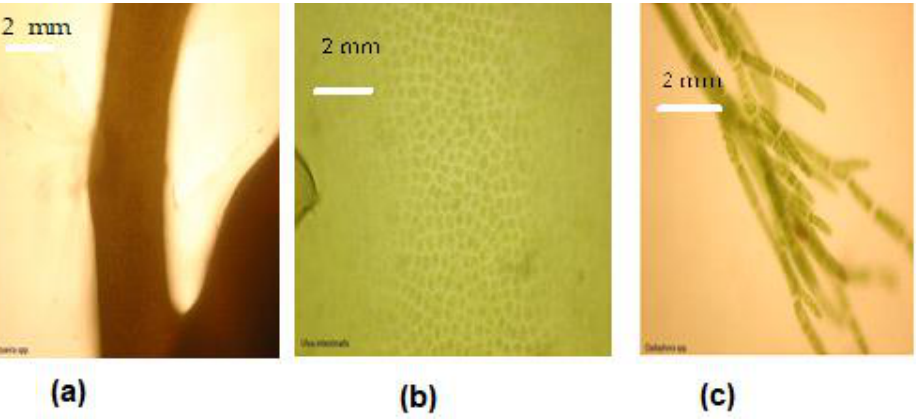
Figure 2 . Microscopic structures of marine algae from Bulgarian Black Sea (magnification 20×) ( a ) E. crinita ; ( b ) U. intestinalis ; ( c ) C. linum.